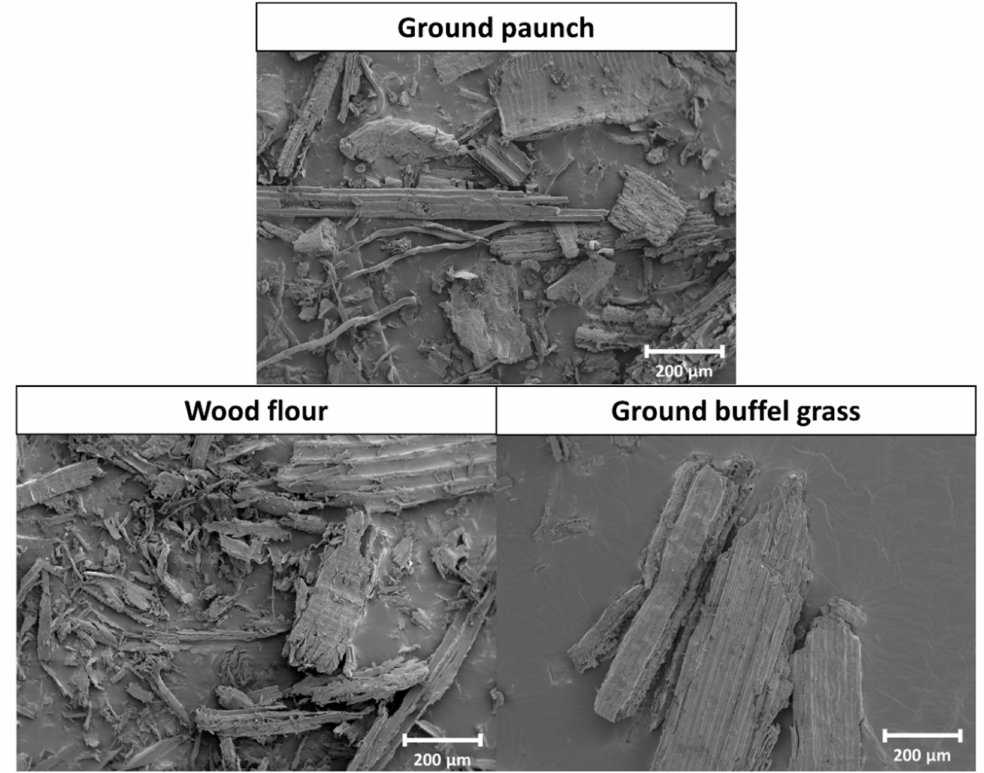
Figure 3. SEM images of ground paunch ( top ), wood flour ( bottom left ) and ground buffel grass ( bottom right ) imaged at 5.00 kV, 10 mm WD and × 100